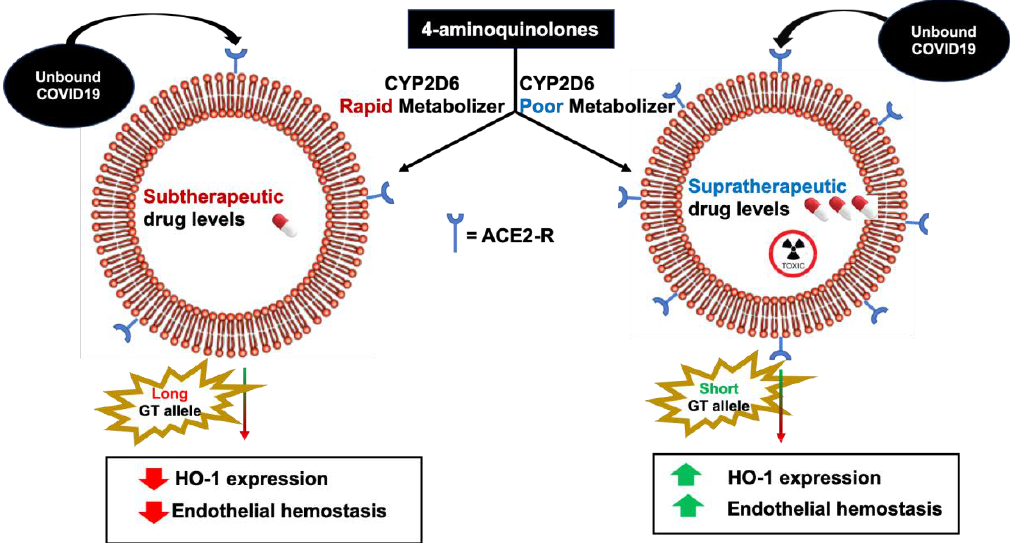
Figure 5. ( Left ) Individuals with the longer GT repeat allele HO-1 genetic polymorphism has lower HO-1 expression and decreased endothelial hemostasis. Rapid CYP2D6 metabolizers develop subtherapeutic drug levels. ( Right ) Individuals with the shorter GT repeat allele have higher HO-1 expression and increased endothelial hemostasis. Poor CYP2D6 metabolizers develop toxic drug levels. The endothelium in all organs can be affected in larger GT allele individuals including the endothelium in the lungs, kidney, and the rest of the cardiovascular system.